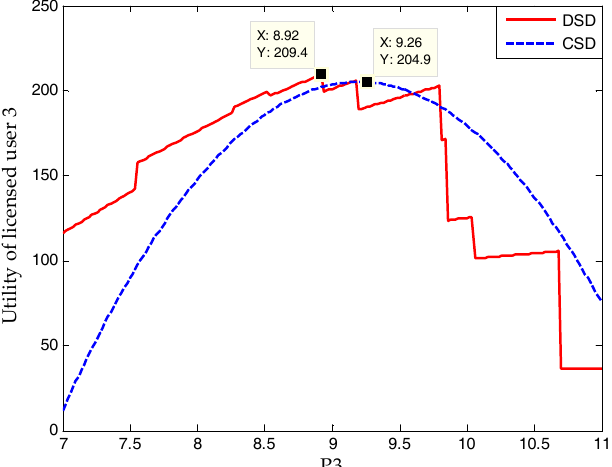
Figure 11. The discontinuous spectrum demand’s influence on licensed user’s utility.